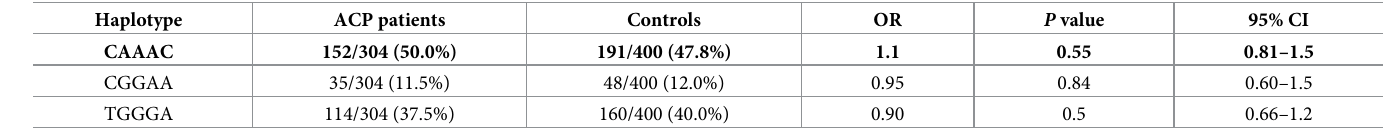
Table 12. Distribution of common PNLIPRP2 haplotype alleles in patients with alcoholic chronic pancreatitis (ACP) and in controls.